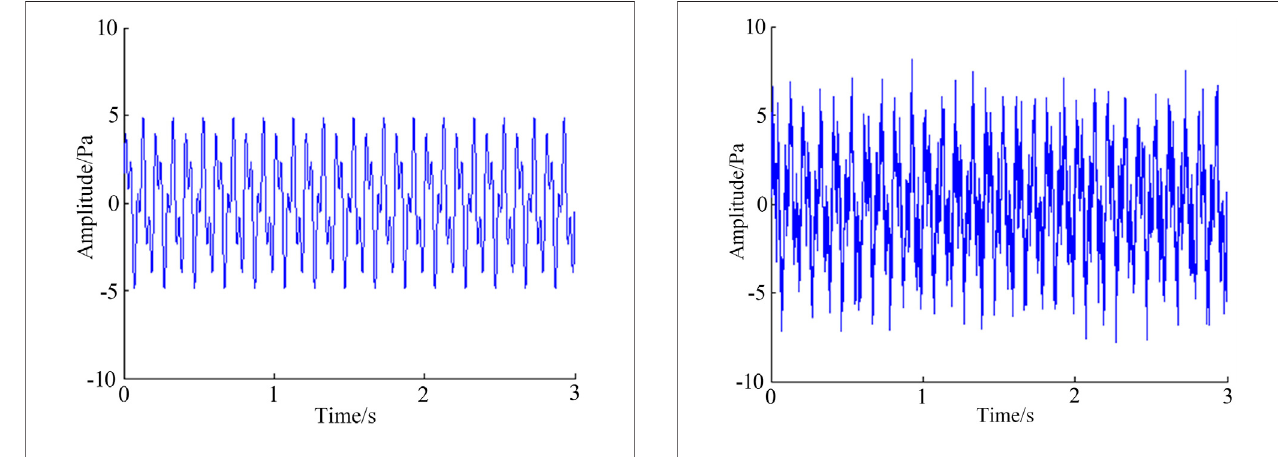
FIGURE 3 | Waveform of the original signal.